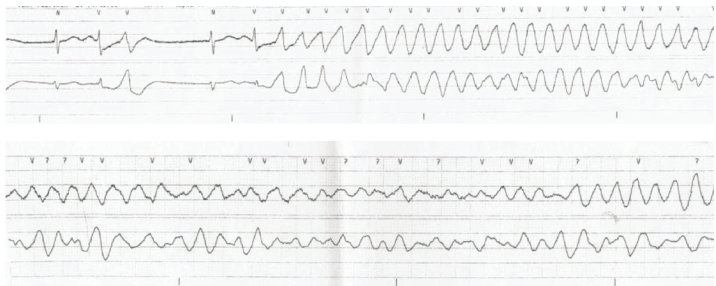
Figure 3: EKG tracing in emergency room showed short-long-short sequence of RR cycle followed by TdP. The patient had two episodes of syncope while he had TdP. The above two tracings are from one of the two